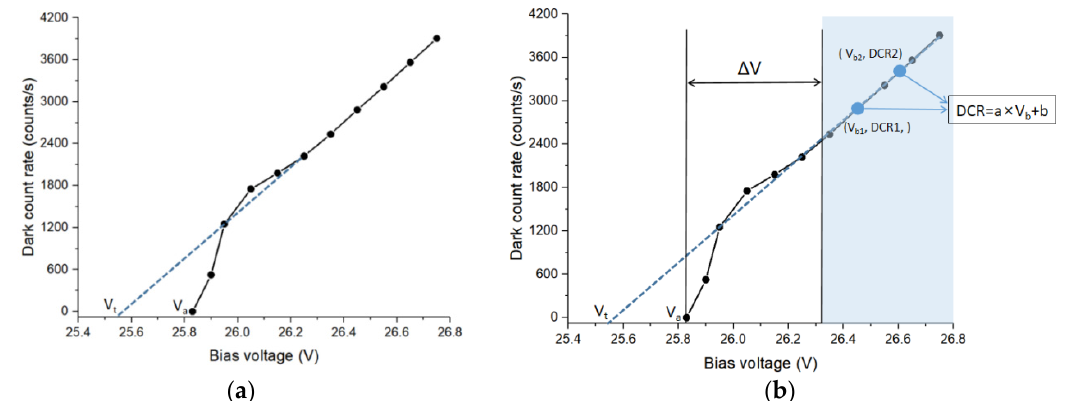
Figure 3. Dark count rate versus bias voltage applied to the SPAD. ( a ) Original plot; ( b ) Calculation of the true breakdown voltage.